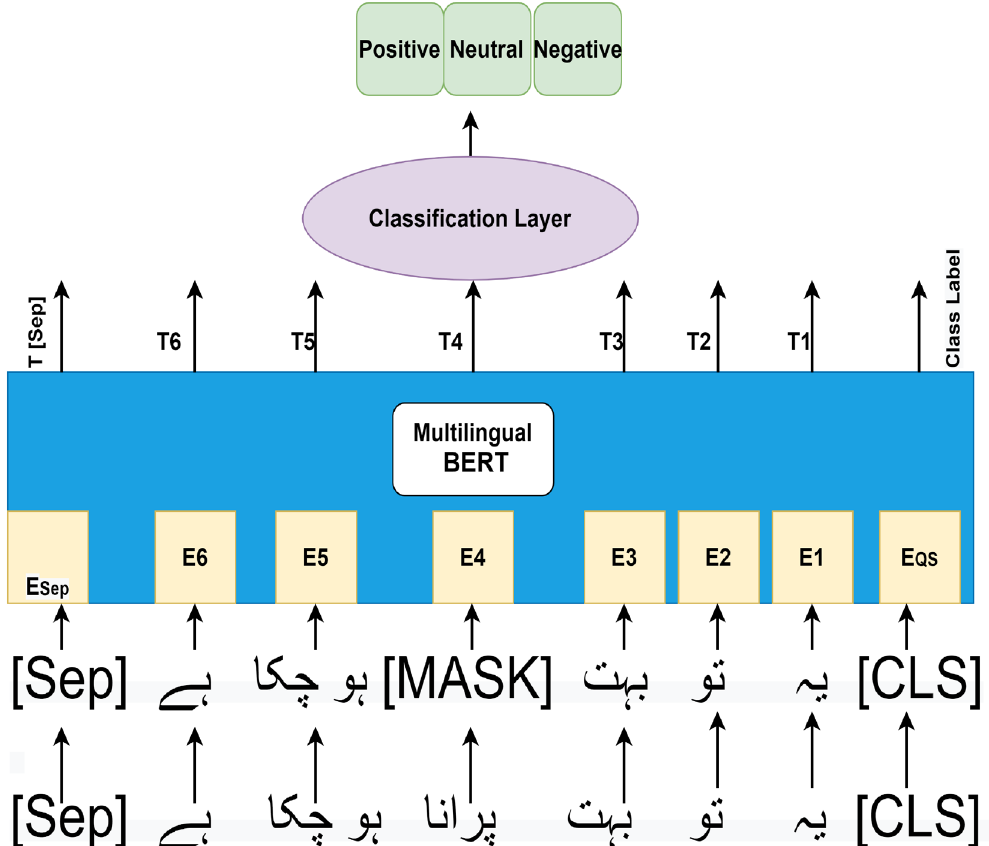
Figure 4. Multilingual BERT high level architecture for Urdu sentiment analysis.